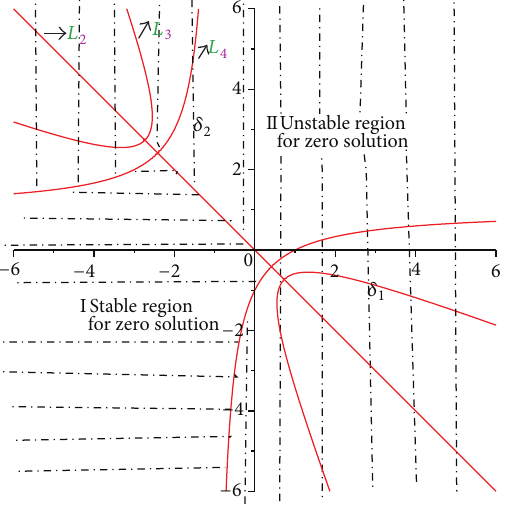
Figure 5: Bifurcation diagram on parameters 𝜇 1 and 𝜇 2 for the case of double zero and a pair of purely imaginary eigenvalues.